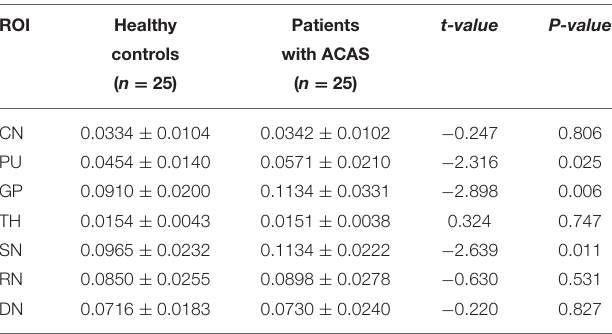
TABLE 2 | Susceptibility (ppm) comparisons in gray matter nuclei between healthy controls and patients with ACAS. ROI